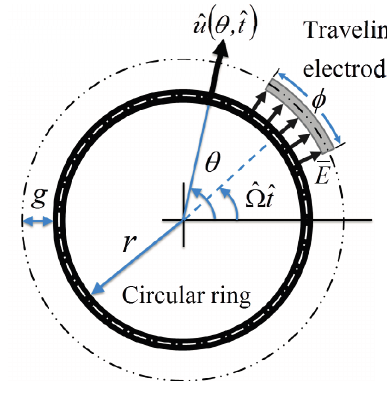
Figure 1. The schematic diagram of a micro circular-ring around which goes an arc-type